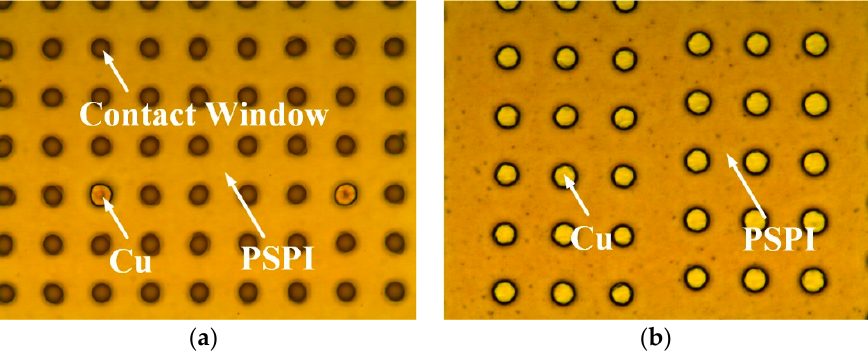
Figure 10. Optical image of patterned contact windows on PSPI after electroplating: ( a ) without plasma bombardment, ( b ) with plasma bombardment.